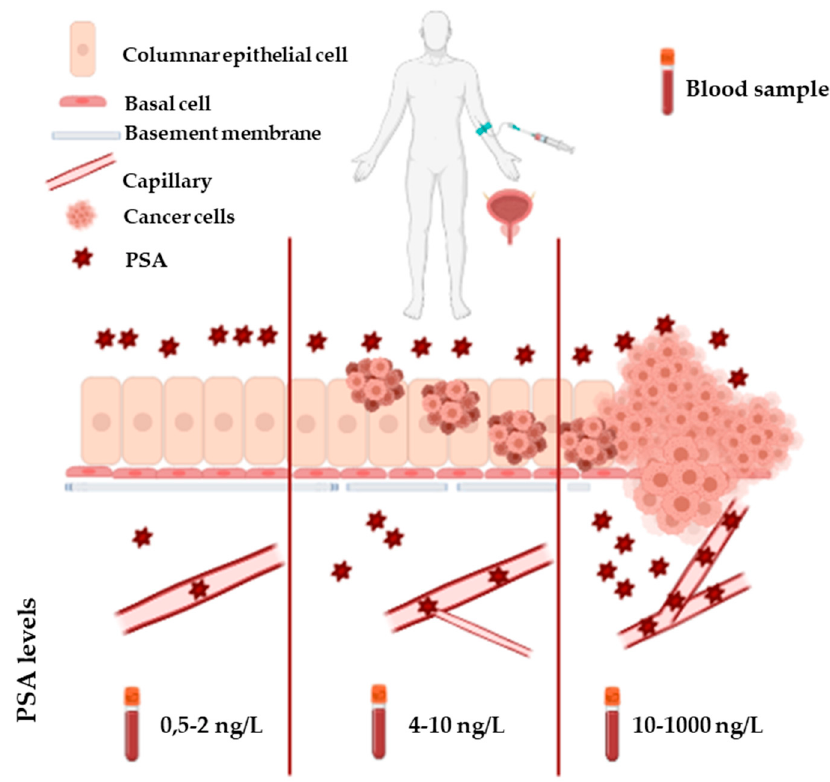
Figure 4. This figure shows the correlation between the alteration of tissue architecture and the increase of serum levels of PSA in